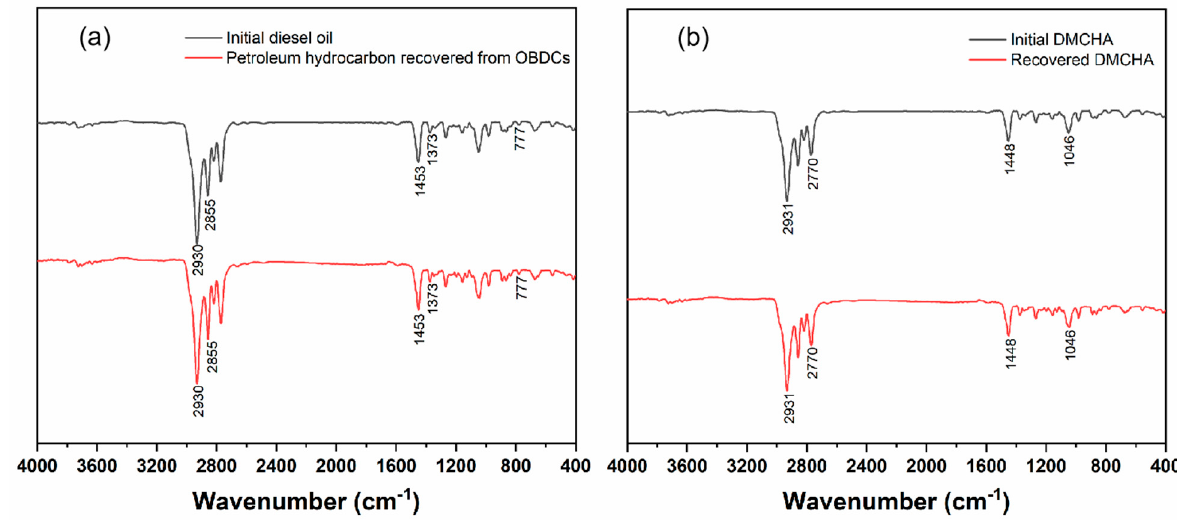
Figure 5. FT–IR spectrums of petroleum hydrocarbon from OBDCs ( a ) and recovered DMCHA ( b ).